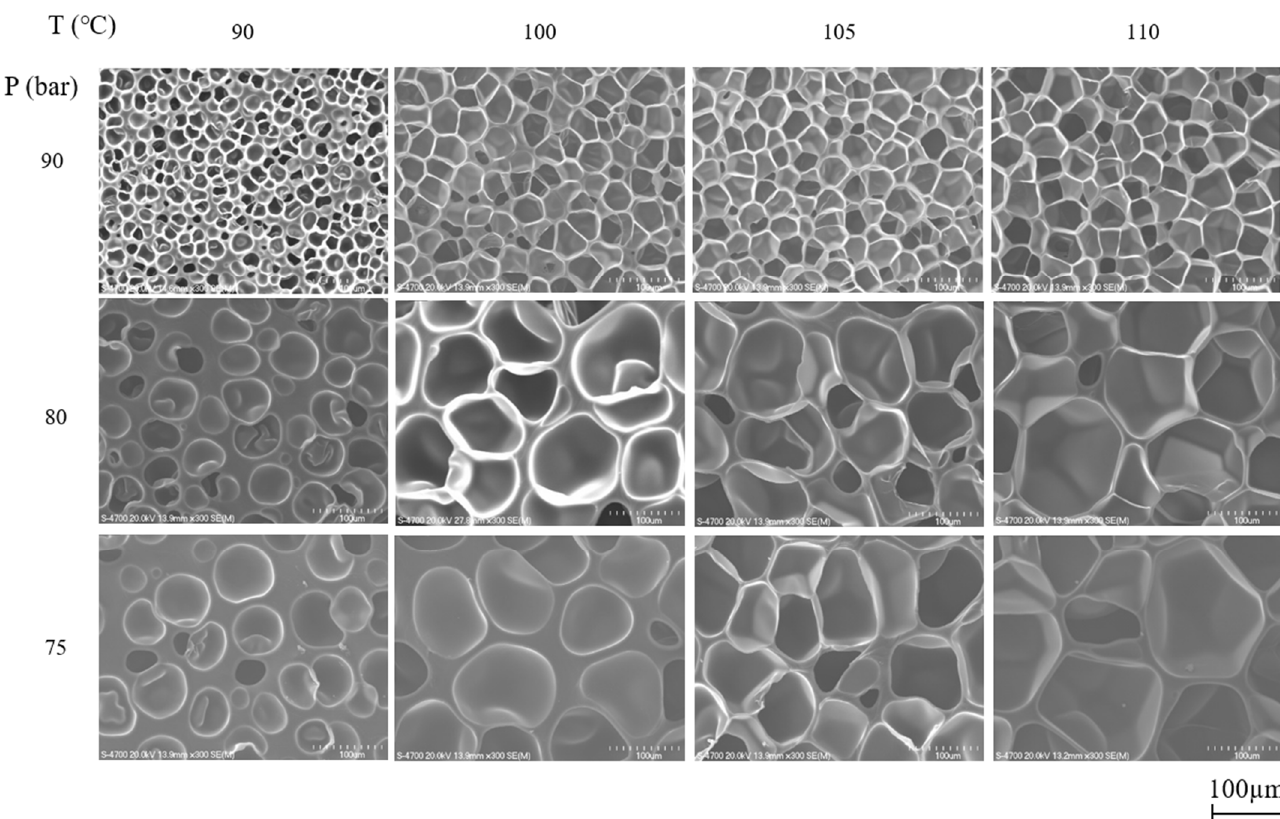
Figure 2. SEM micrographs of ETPU prepared at different foaming temperatures and pressures in the supercritical CO 2 foaming process .